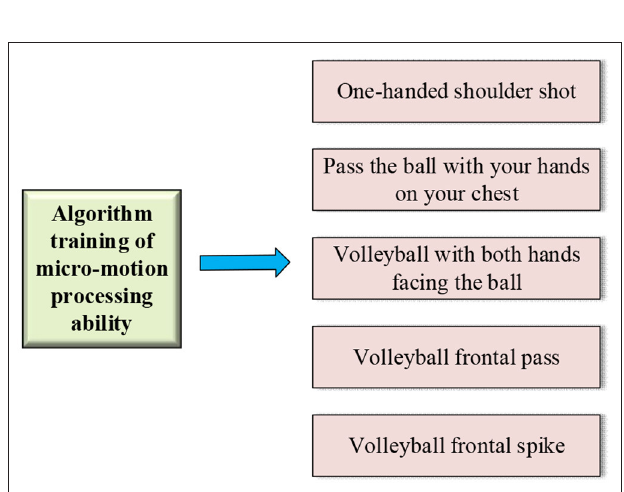
FIGURE 7 | The proposed KELM-MFF-based HMR algorithm’s training mode of micromotion processing